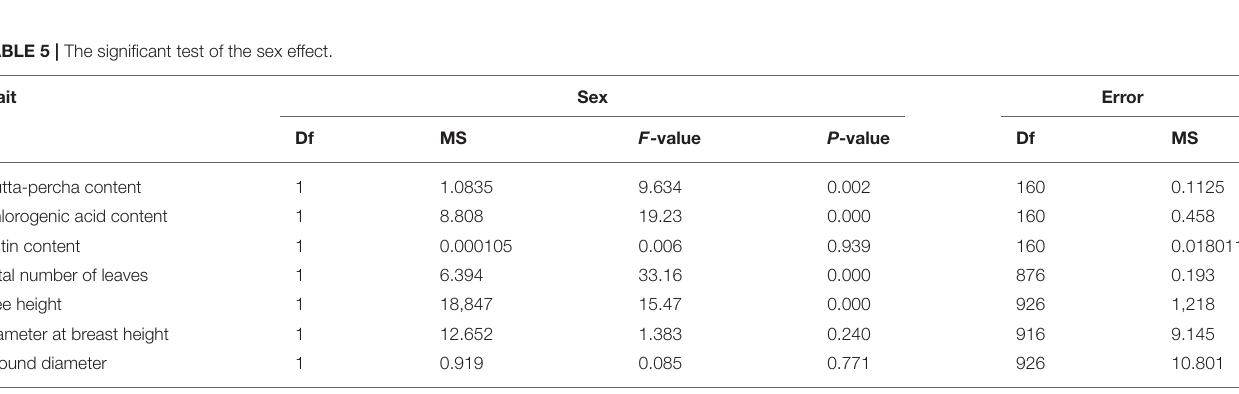
TABLE 5 | The significant test of the sex